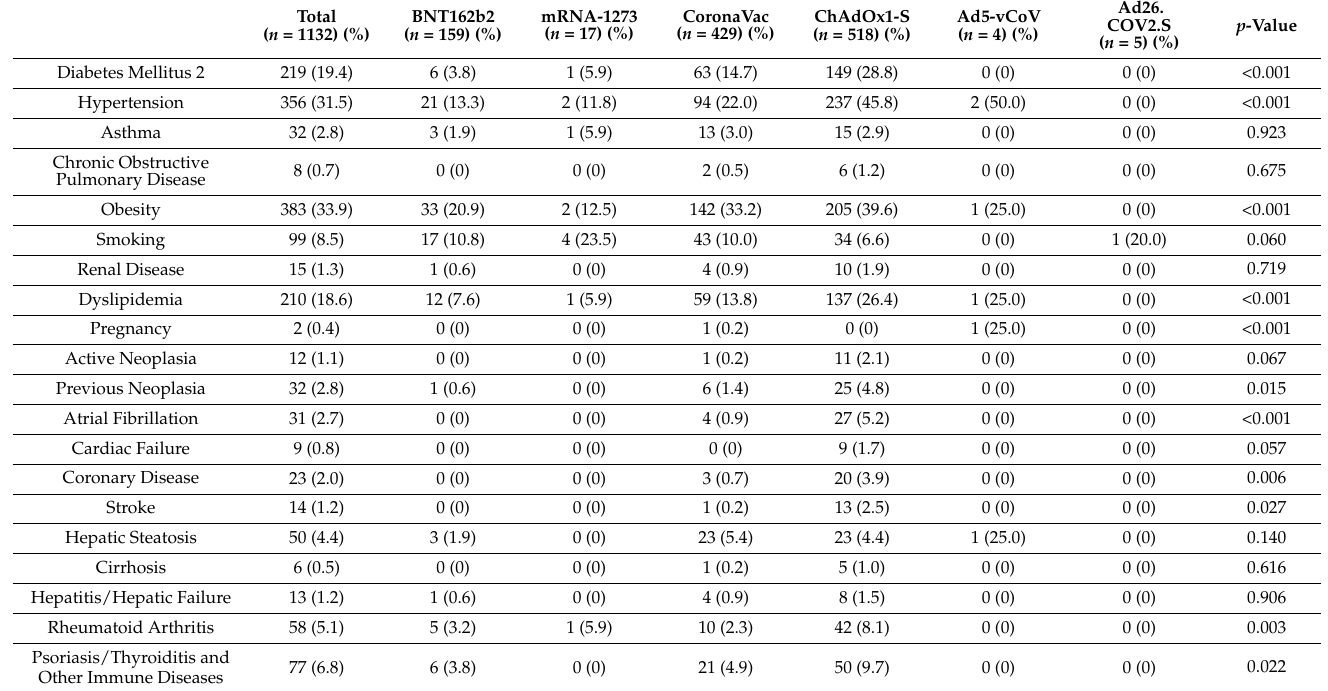
Table 1. Medical